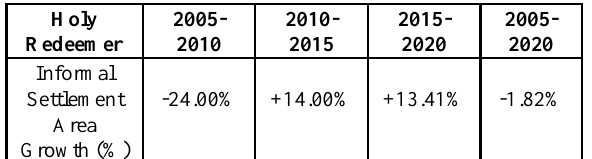
Figure 8. Informal Settlement in Brgy. Tandang Sora